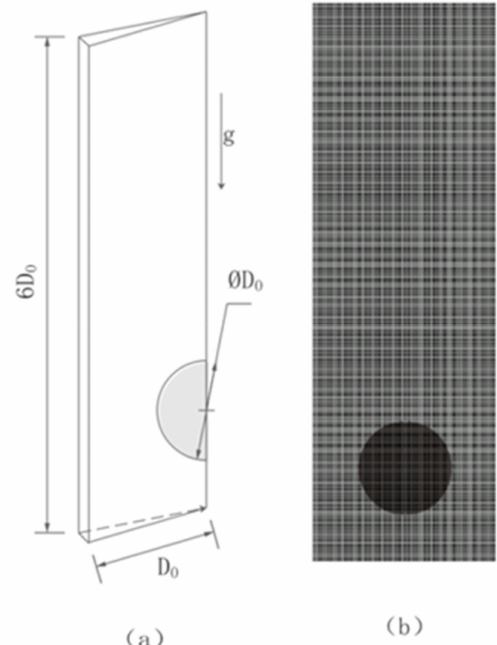
Figure 4. The diagram of computational domain and mesh. (a) Schematic model of computational domain; (b) The mesh in computational